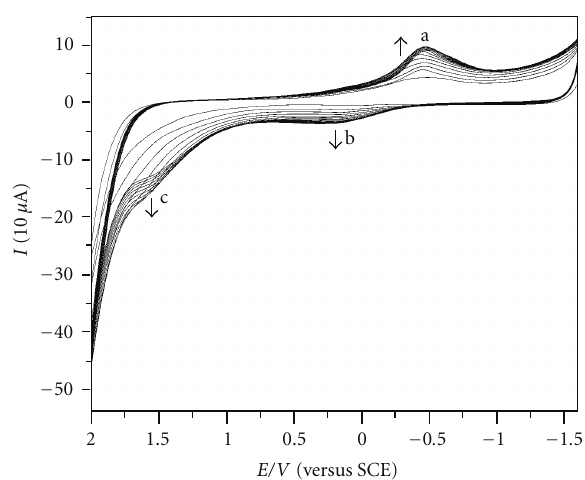
Figure 2: Cyclic voltammogramsof 2.0 × 10 − 5 molL − 1 safranine at the GCE in PBS (pH 6.0) at a scan rate of 100mVs − 1